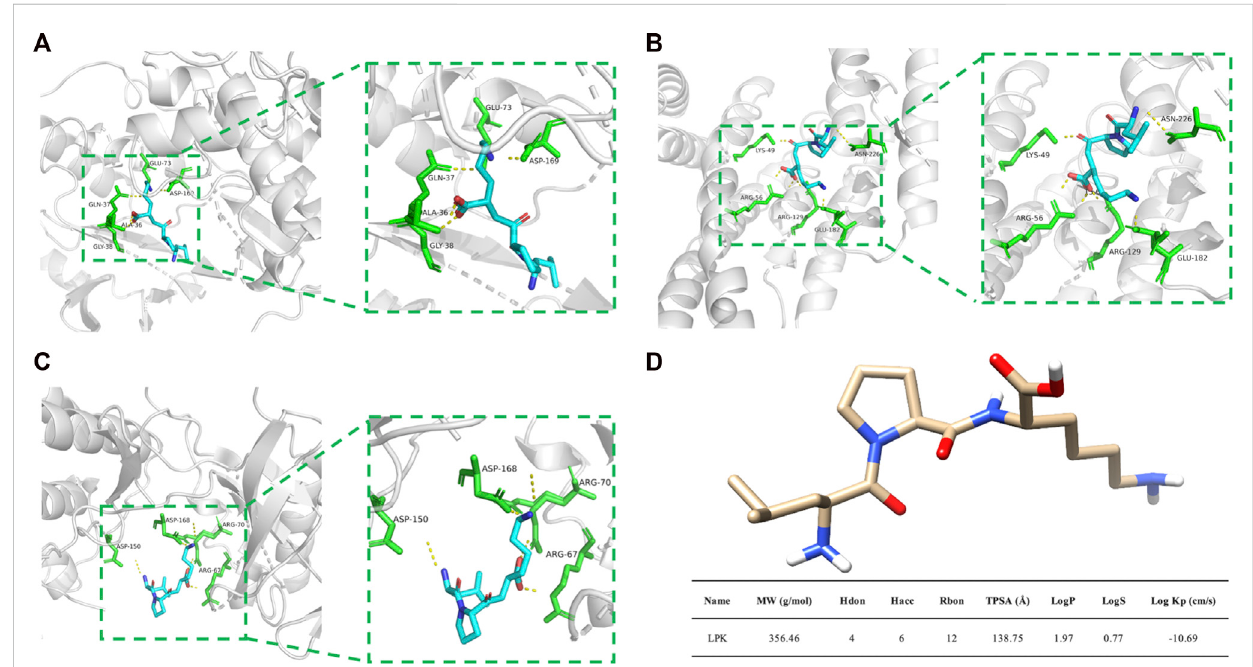
FIGURE 5 Molecular docking results and LPK structure. (A) The binding model of LPK and MAPK8. (B) The binding model of LPK and ESR1. (C) The binding model of LPK and MAPK14. (D) LPK structure and ADME results. Note: The yellow dotted lines represent the hydrogen bonds, the green rod structures represent the amino acids bound to LPK, and the blue rod structures represent the LPK structure.